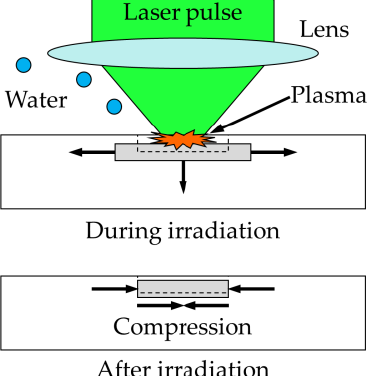
Figure 2. Mechanism of residual stress improvement by laser irradiation.